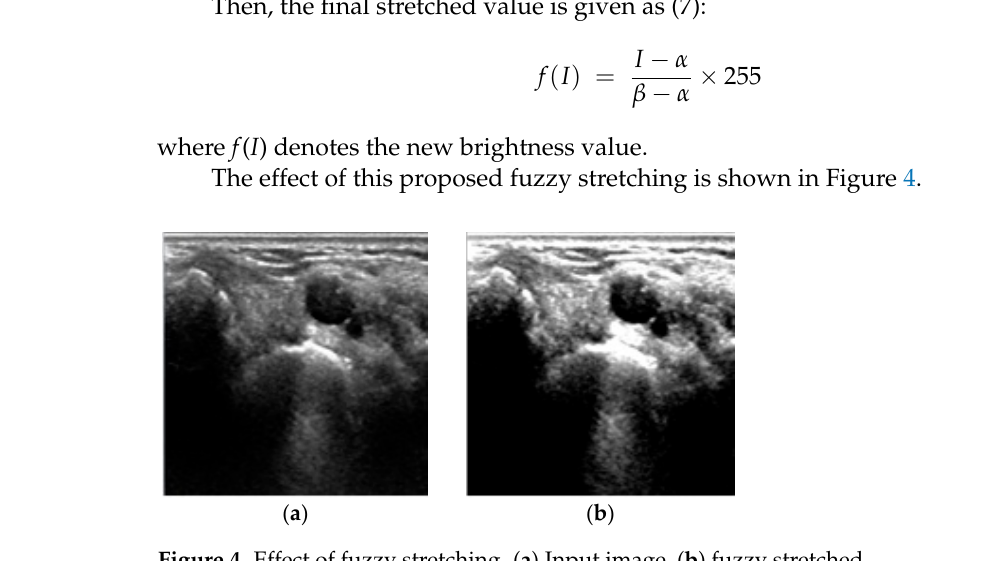
Figure 4. Effect of fuzzy stretching. ( a ) Input image, ( b ) fuzzy stretched.